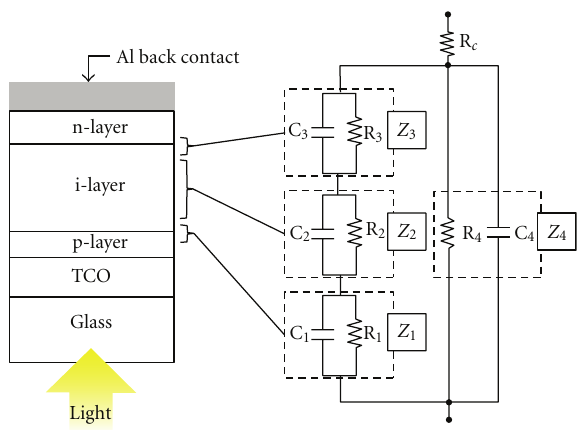
Figure 1: Equivalent circuit diagram of solar cell impedances, formed by a combination of resistors and capacitors.